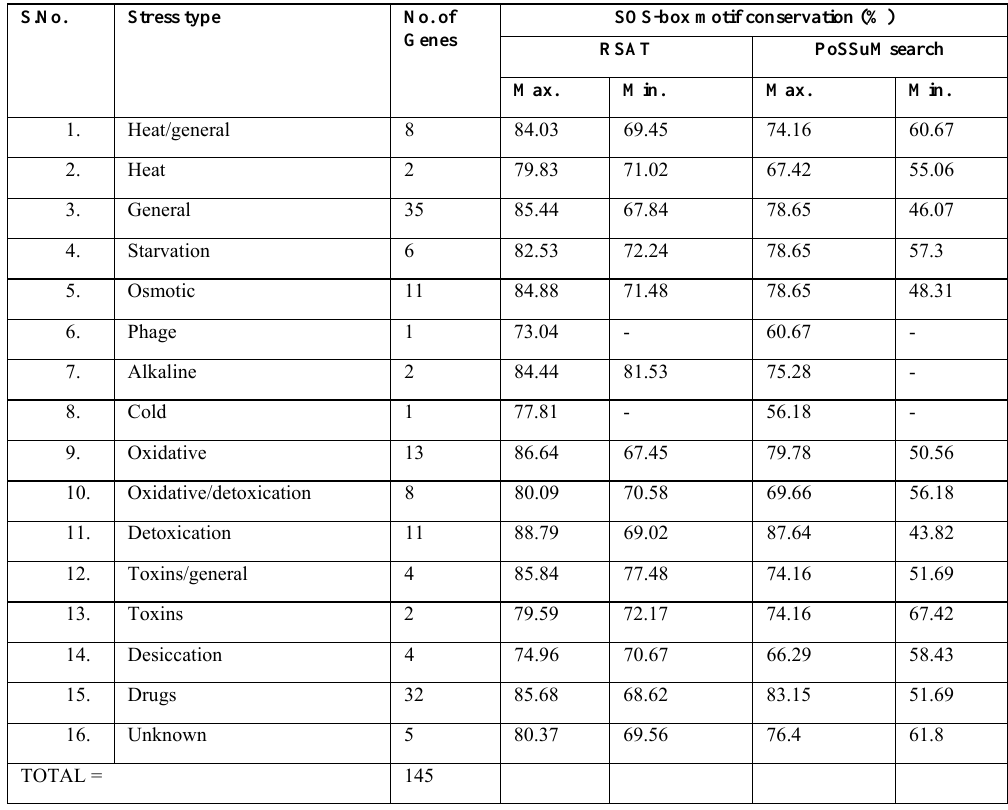
Table 5: Comparison of SOS-box motif conservation (in %) predicted through both RSAT & PoSSuMsearch programs in D. radiodurans genes related to different stress types.